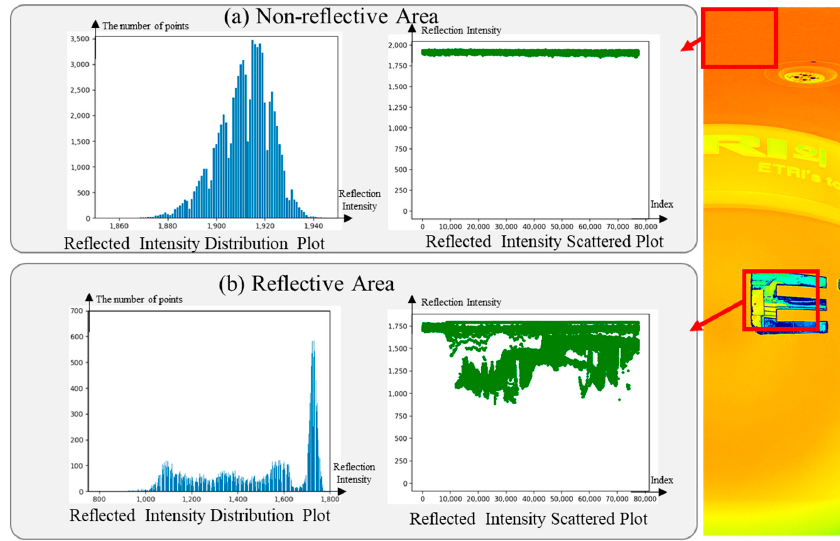
Figure 7. Point cloud to range image schematic. The red dot in the figure represents part of the point cloud data, and the range image can be obtained by topology